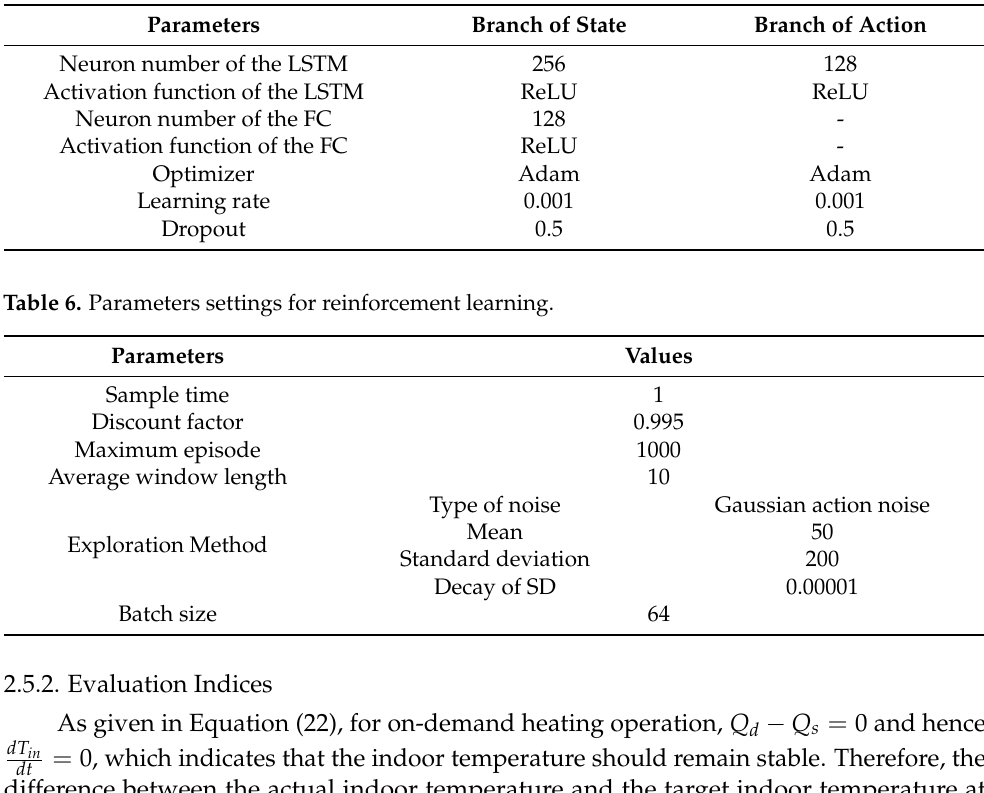
Table 5. Parameters settings for the Critic network.